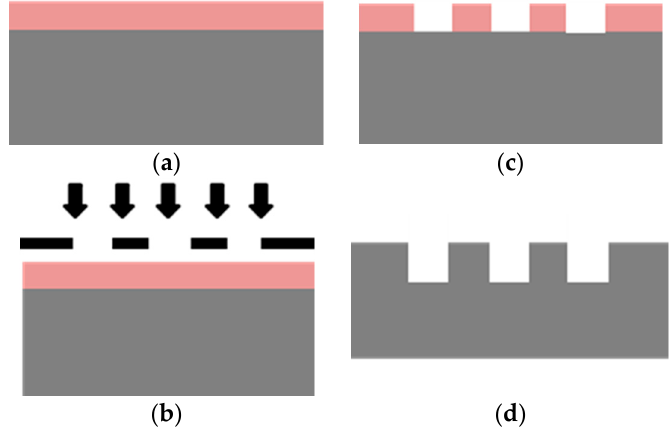
Figure 3. The diagram of silicon microchannel fabrication process ( a ) Photoresist as etching mask coating; ( b ) Transfer pattern using photolithography; ( c ) Pattern development using resist developer; ( d ) Si DRIE along the unprotected microchannel lines & photoresist removal.